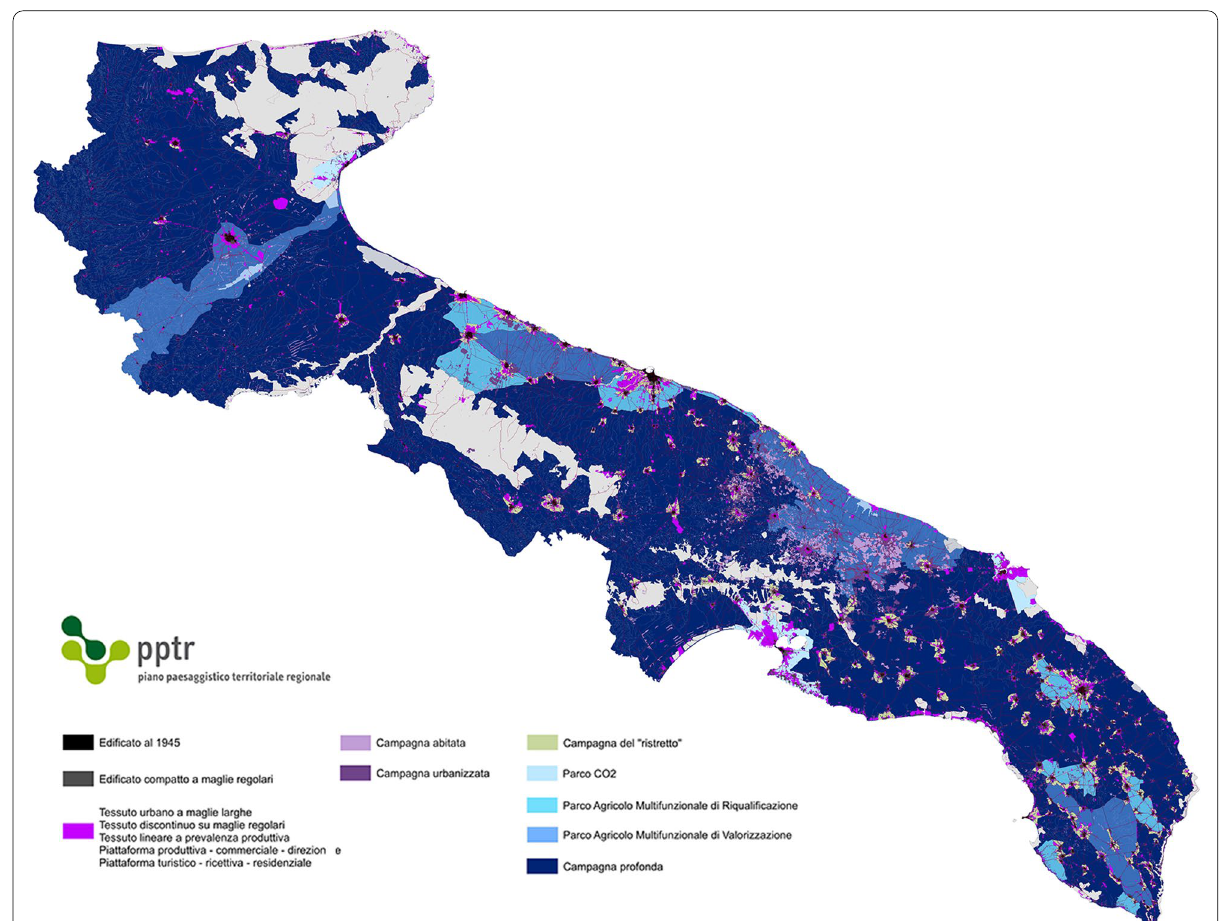
Fig. 1 The territorial project of the City-Country Pact. The City-Country Pact strategy divides the territory into three macro categories. The first (left column) refers to urban settlements articulated through historical centres, compact cities, residential peripheries, industrial areas, and tourist and commercial settlements. The second one (central column) interprets rural sprawl through the inhabited countryside (low density and agricultural and residential uses) and urbanised countryside (high density and residential use). The third category (right column) interprets open space relating to the degree of integrity of rural characteristics: ‘ ristretto’ countryside, C02 Park associated with forestation, Multifunctional Agricultural Regeneration or Valorisation Park and Deep countryside. While the grey areas of the map indicate protected natural areas governed by specific protection plans. Source: PPTR, elaborate 4.2.2